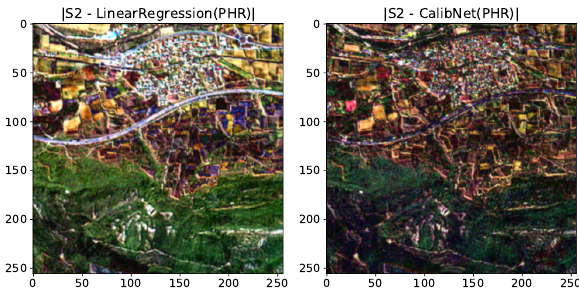
Figure 13. Prediction error of Linear Regression and CalibNet on Aude2